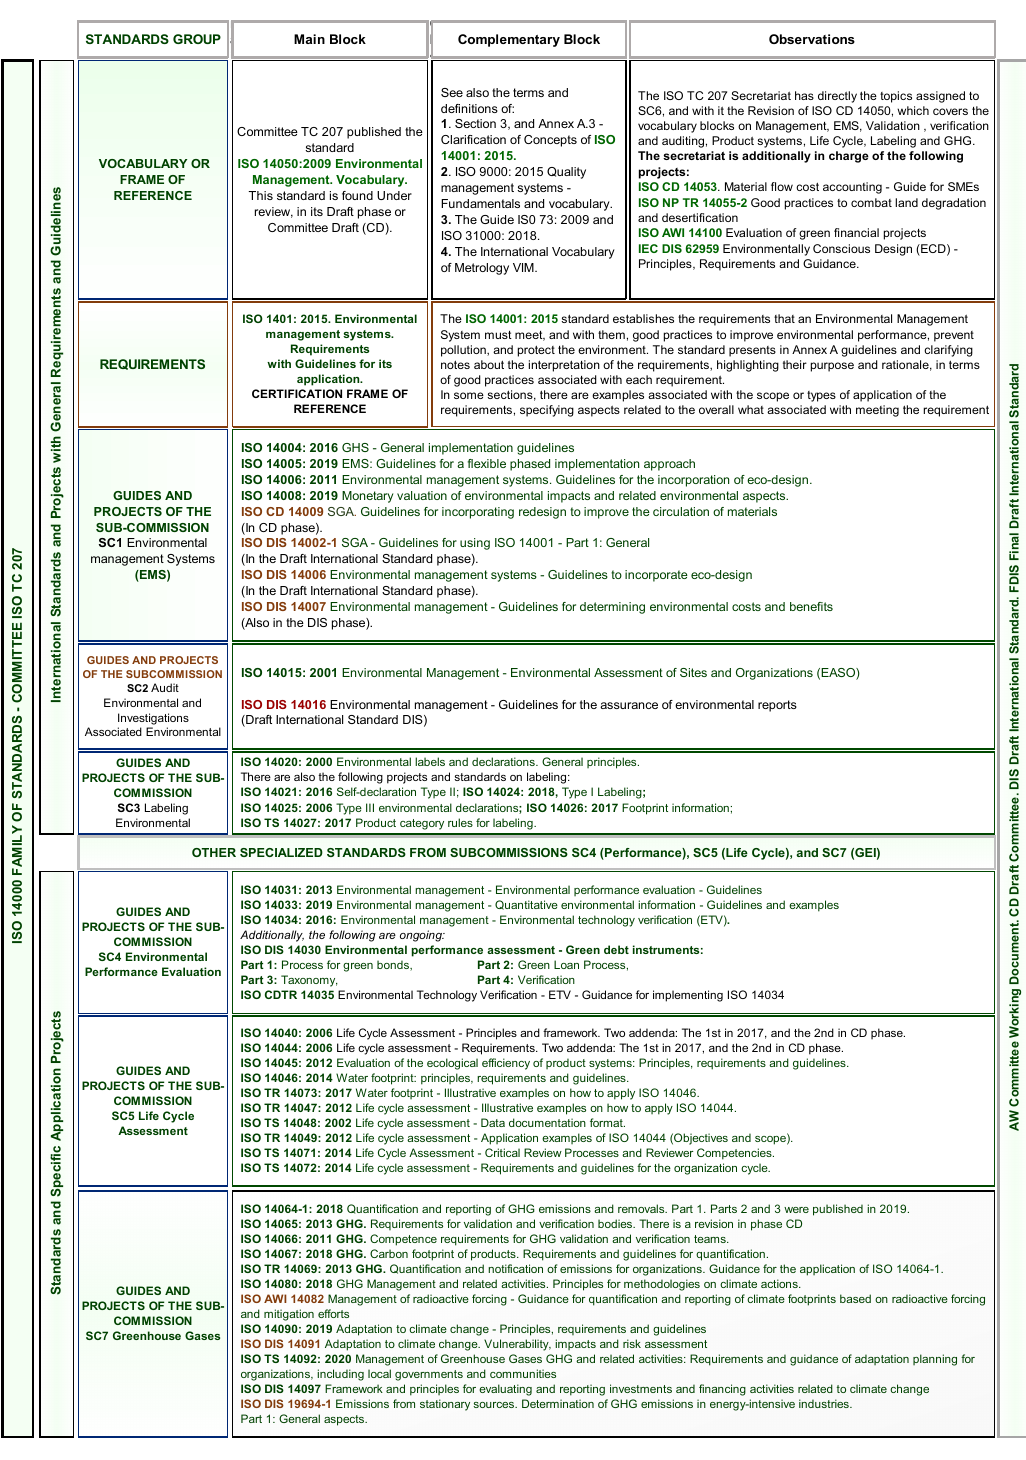
Figure A4. Approach and Logical Structure of the ISO 14000 Family of Standards [27,31].